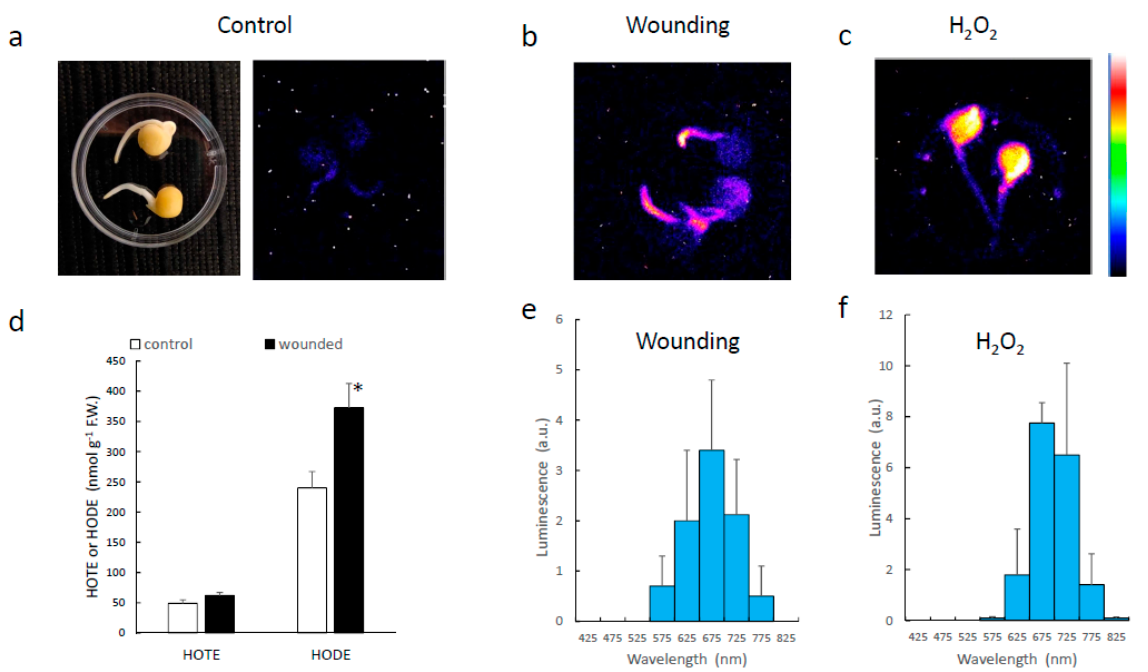
Figure 5. SCL in pea roots. ( a ) SCL emission from control pea seeds. Seeds were left to germinate on wet filter paper for 3 d. ( b ) SCL of pea seeds with wounded roots. ( c ) SCL of seeds exposed for 4 h to hydrogen peroxide. ( d ) HOTE and HODE levels in pea roots before and after wounding. *, significantly different from control at p < 0.01 (Student’s t -test). ( e ) SCL spectrum of wounded pea roots. ( f ) SCL spectrum of pea roots exposed to hydrogen peroxide.